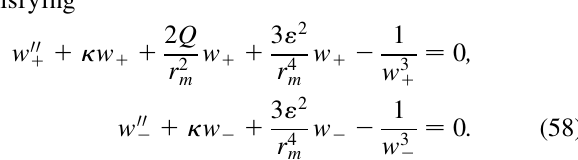
FIG. 6. Round, matched beam envelope with r a continuous or solenoidal focusing channel with pure breath- (cid:1) %r ) and quadrupole ( %r ing ( %r x y tions